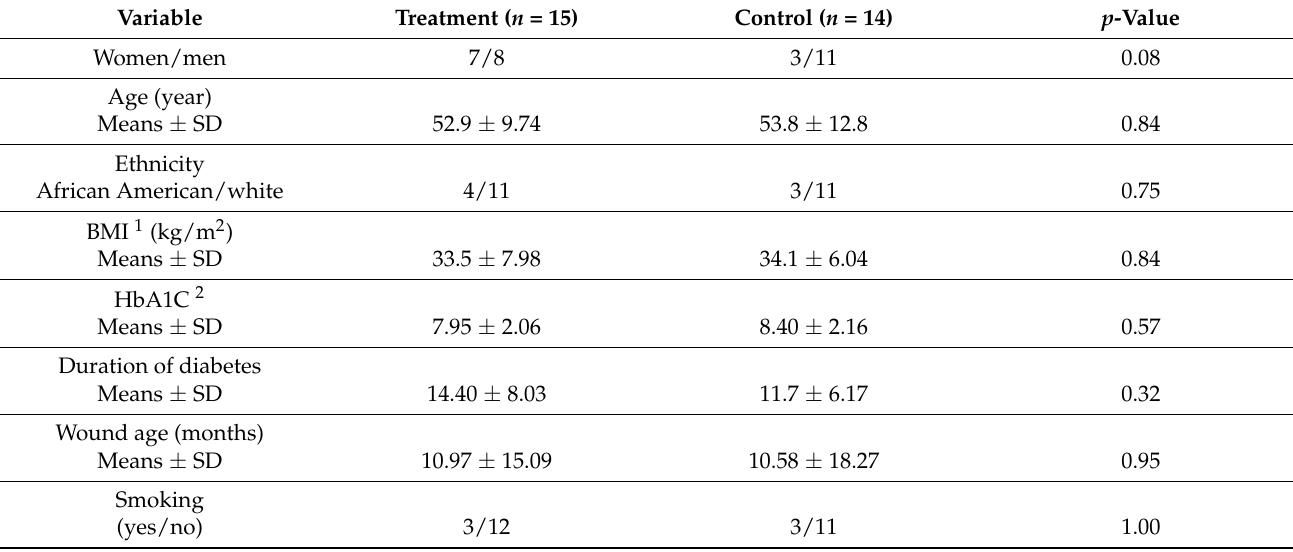
Table 2. Baseline characteristics of participants, according to